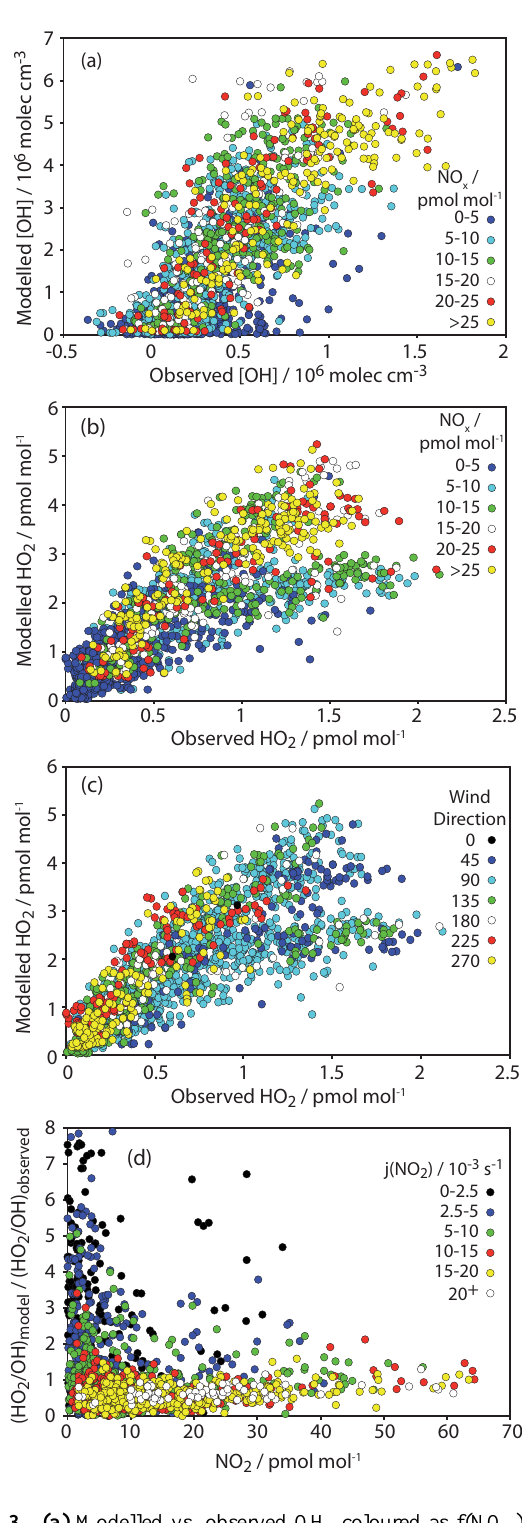
Fig. 3. (a) Modelled vs. observed OH, coloured as f(NO x ); (b) Modelled vs. observed HO 2 , coloured as f(NO x ) ; (c) Modelled vs. observed HO 2 coloured by wind direction (legend denotes centre of 45 ◦ sector, expressed in degrees from North) and (d) Ratio of modelled to observed HO 2 :OH ratio as a function of NO 2 , coloured according to j (NO 2 ) .